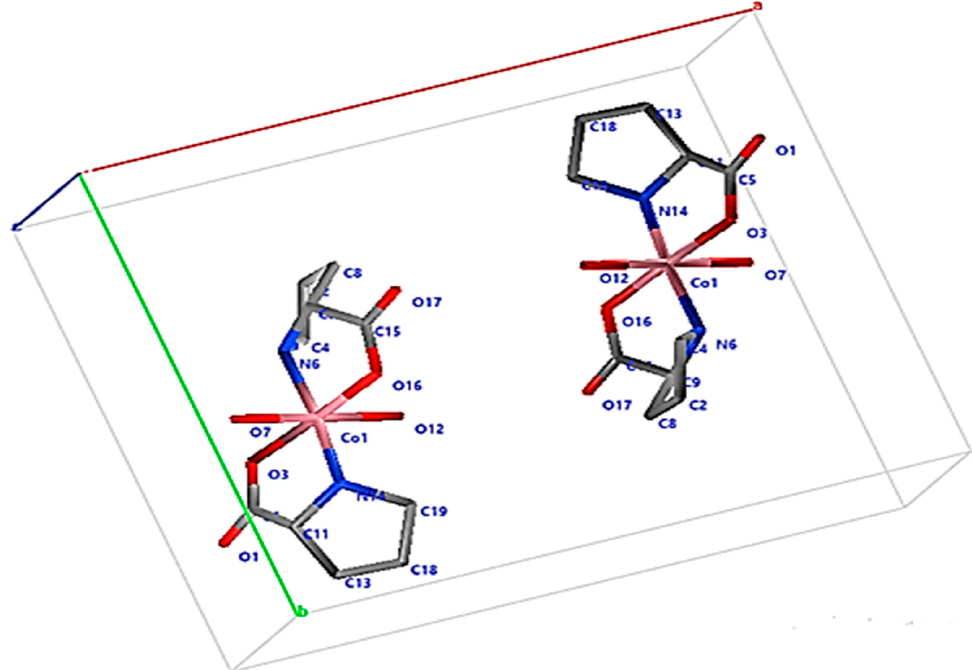
Figure 10. Crystal structure of PCC